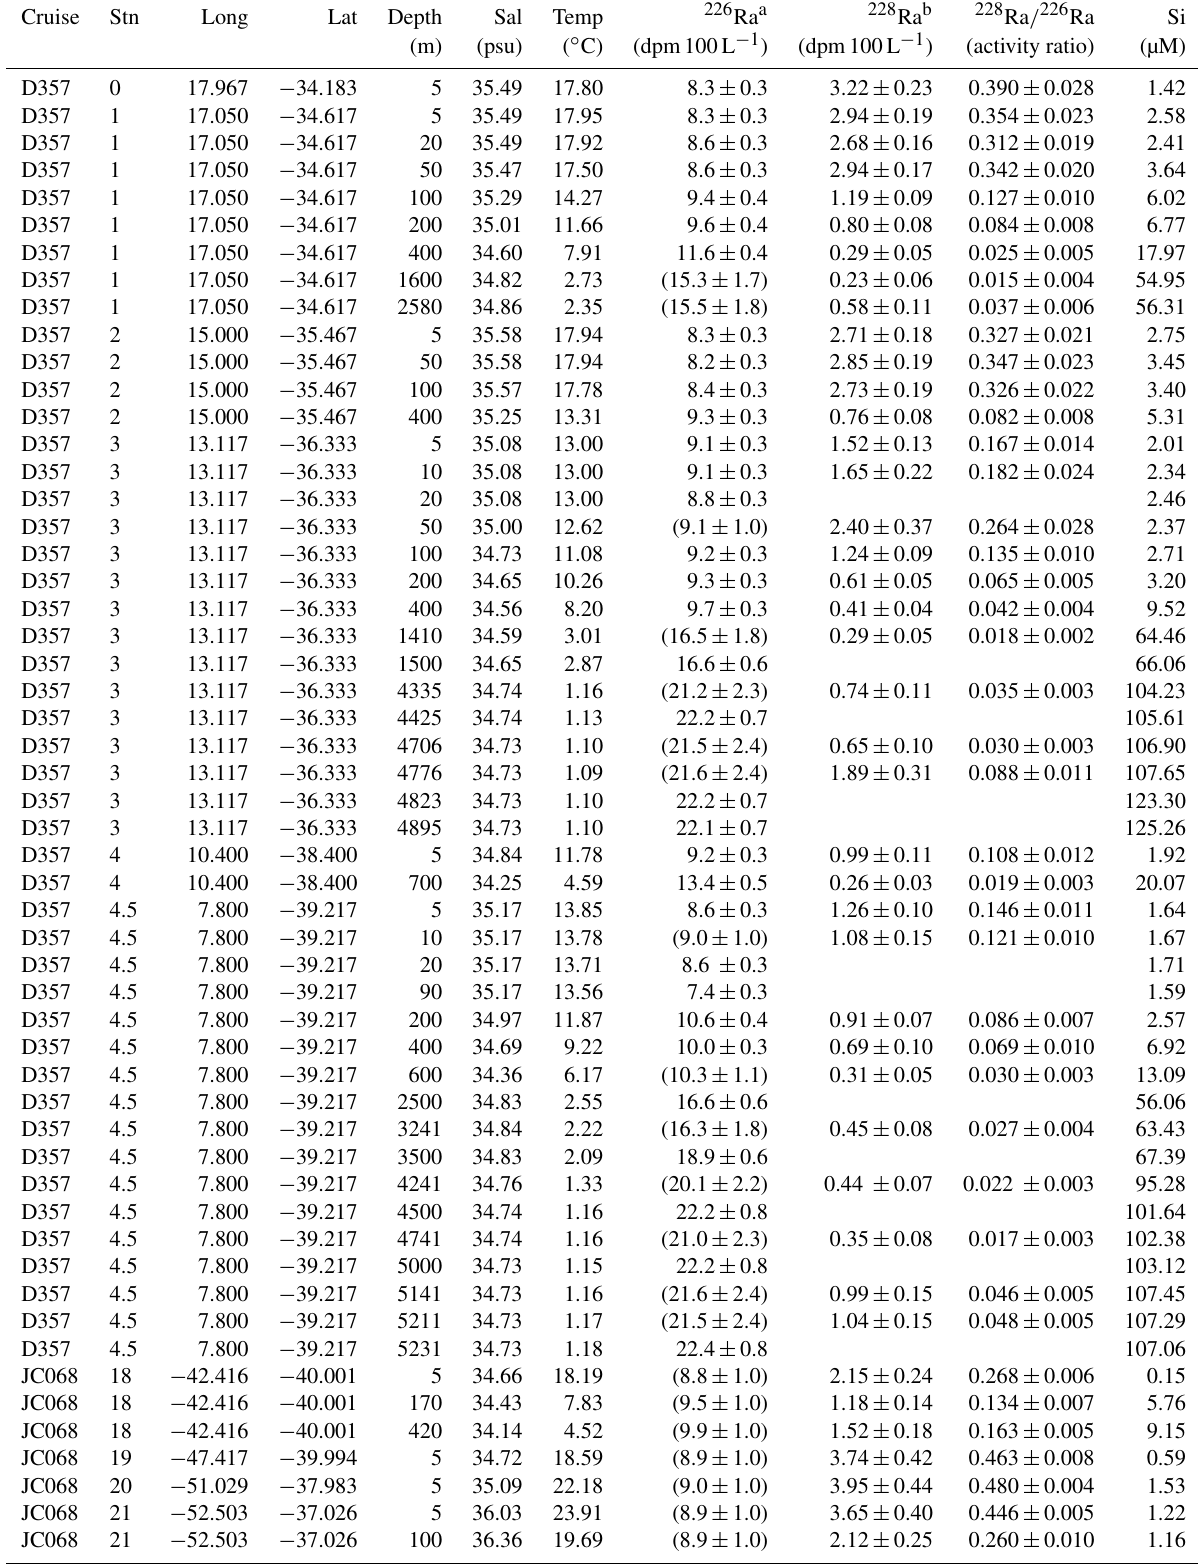
Table 1. 226 Ra and 228 Ra activities, 228 Ra / 226 Ra activity ratios, and silica